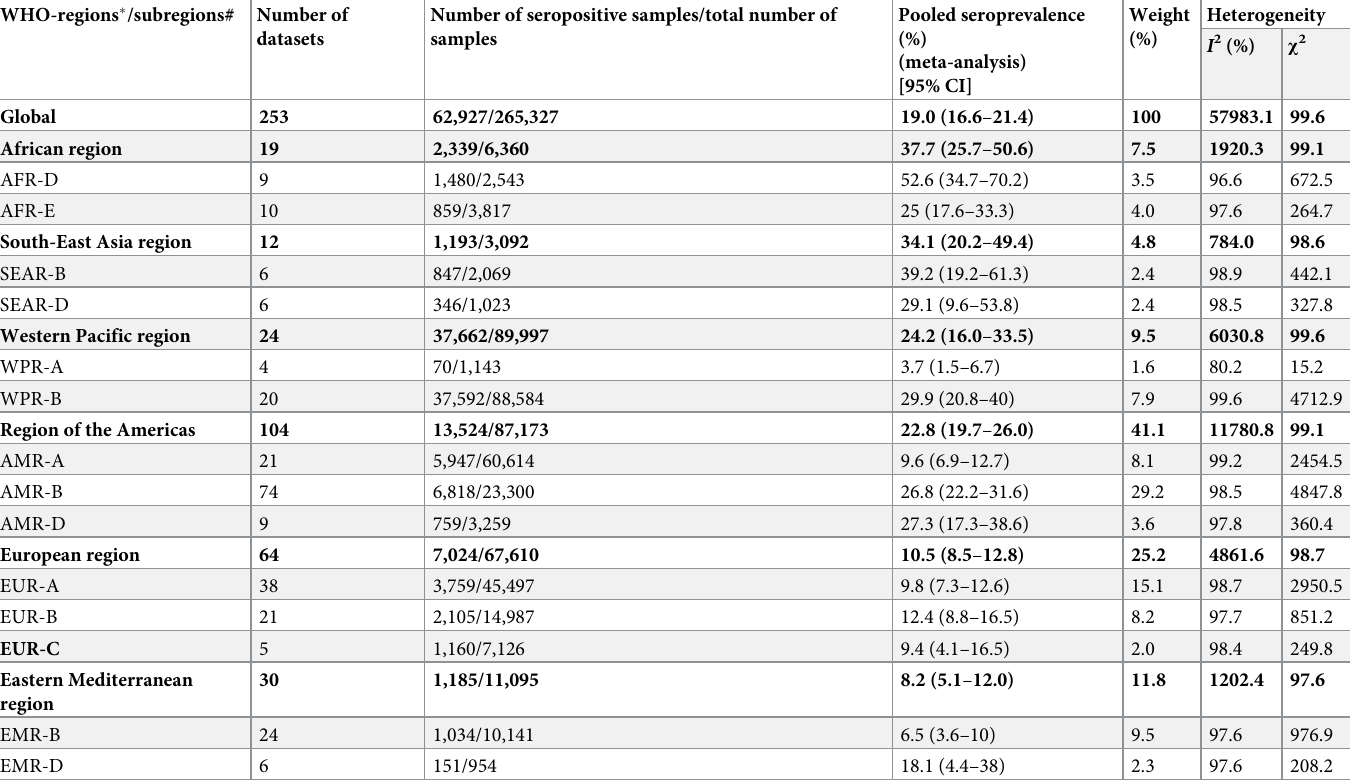
Table 1. Global, regional and sub-regional pooled T -seroprevalence (results from 250 studies performed in 71 countries). Number of seropositive samples/total number of WHO-regions � /subregions# Number of datasets samples